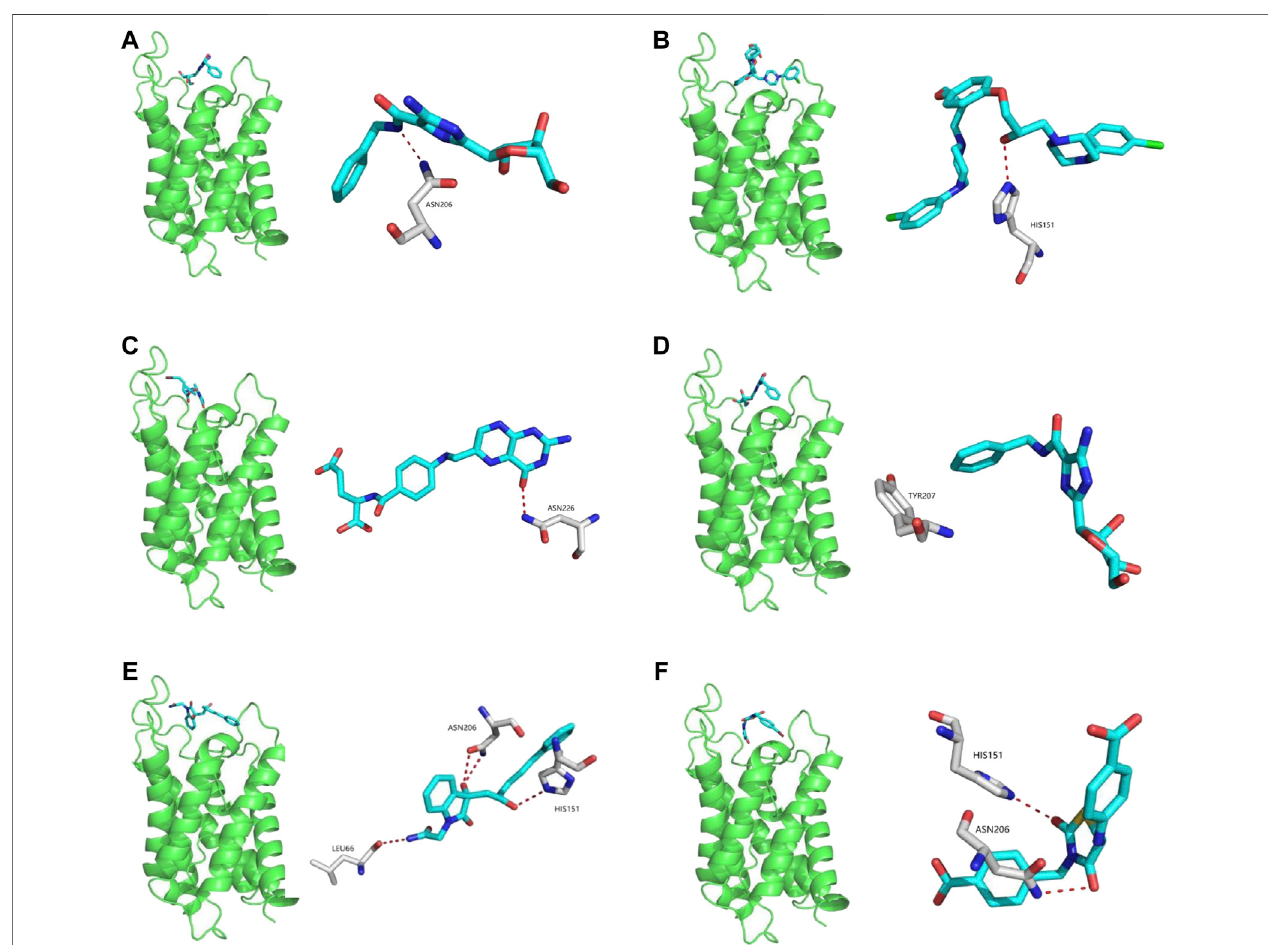
FIGURE 8 | Virtual screening of potential AQP4 inhibitors and molecular docking analysis. The docking conformation of the top six small molecules with the modeling protein is provided and the docking mode and important residues are given.